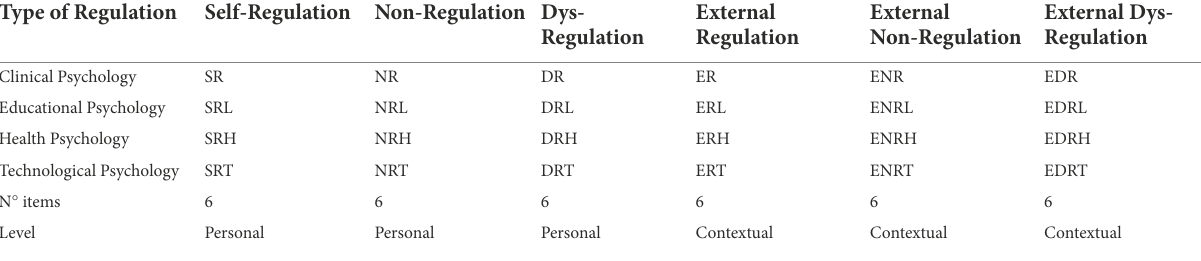
TABLE 2 Table-summary of the types of regulation in the